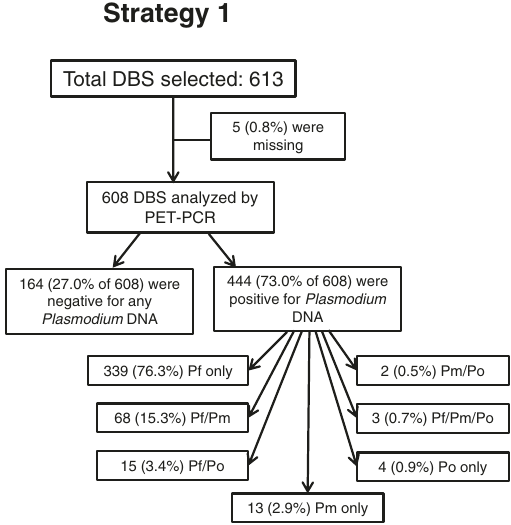
Fig. 1 | Number of dried blood spot samples selected for PET-PCR by selection strategyand theirresults:Nigeria,2018. Strategy1 involved selecting DBSbased on a low or negative HRP2 assay signal compared to other Plasmodium antigen targets.Strategy2selectedarandomsampleofHRP2positiveDBS,withatargetof